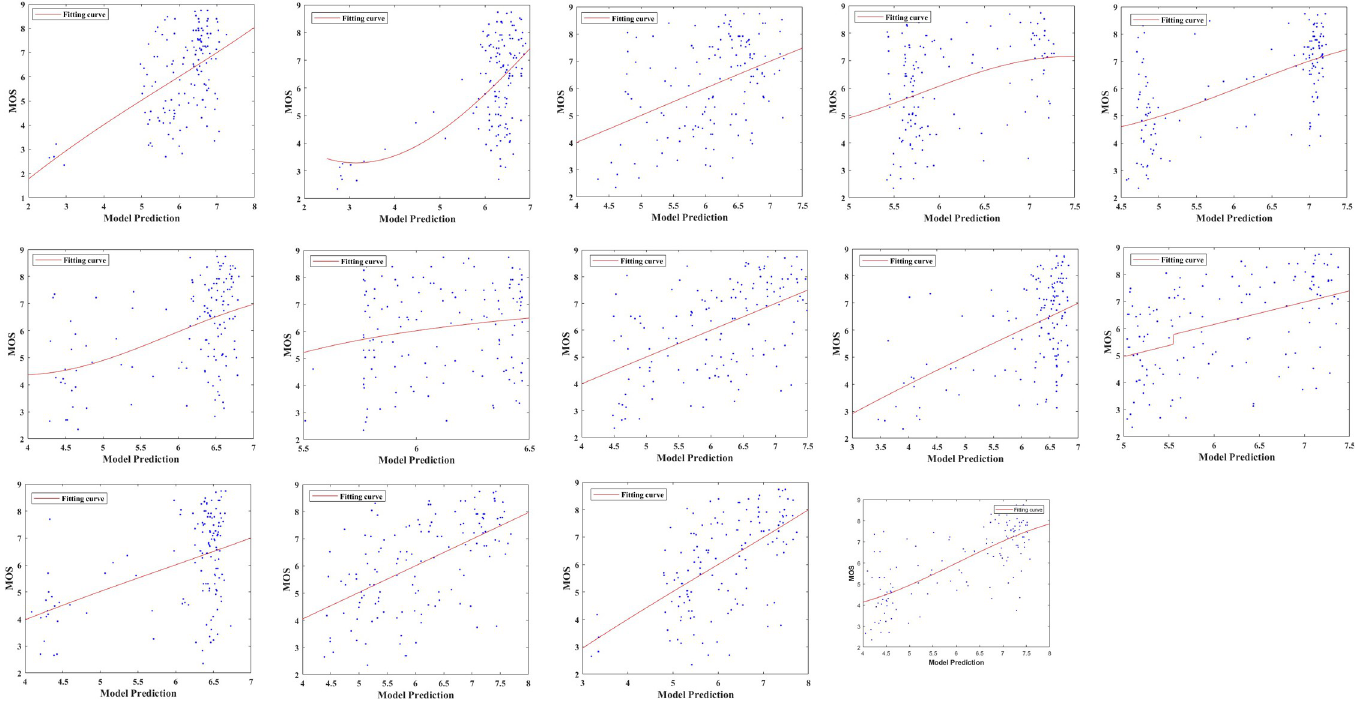
Fig 4. Scatter plots for the objective predicted scores and MOS values of sixteen NR-IQA methods. (a) DIIVINE [16]; (b) BLINDS_II [17]; (c) BRISQUE [18]; (d) CurveletQA [19]; (e) GradLog [21]; (f) ContrastQA [20]; (g) GLBP [22]; (h) OG [23]; (i) NIQMC [25]; (j) SCORER [26]; (k) BTMQI [31]; (l) HIGRADE-1 [32]; (m) HIGRADE-2 [32]; (n) Proposed.